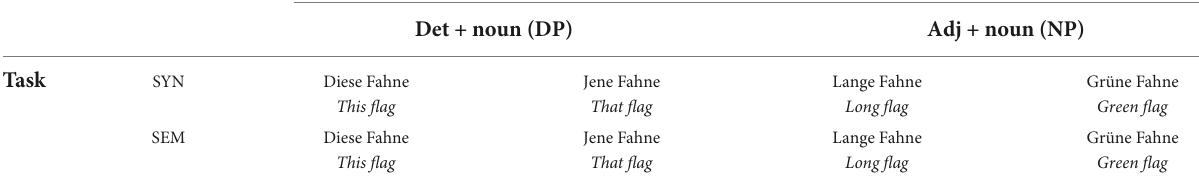
TABLE 1 Experimental